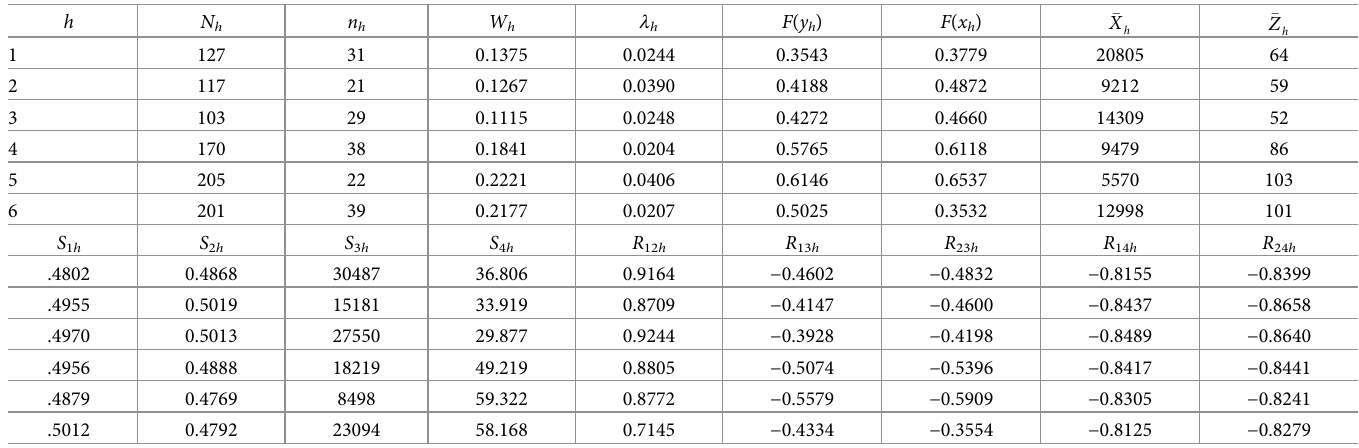
Table 9. Summary statistics for Population